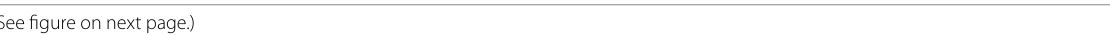
figure on next Fig. 5 The variation in phylum relative abundance with season, sex, and immune indices. a Stacked bar plots of phylum relative abundance per sample. Note that the large phylum Proteobacteria was divided into the three classes present. b Boxplots of the relative abundances of the five most abundant phyla. The data is organized per sex and season (S summer, W winter), starting with the summer of 2013. The relationships = = between the logit(proportion) of Bacteroidetes and BMR c , the logit(proportion) of Firmicutes and body mass d and BSA titre e , the logit(proportion) of Fusobacteria and residuals of the haemolysis titre f , and the logit (proportion) of Gammaproteobacteria and BSA titre g are presented in separate panels. Statistics are presented in Table